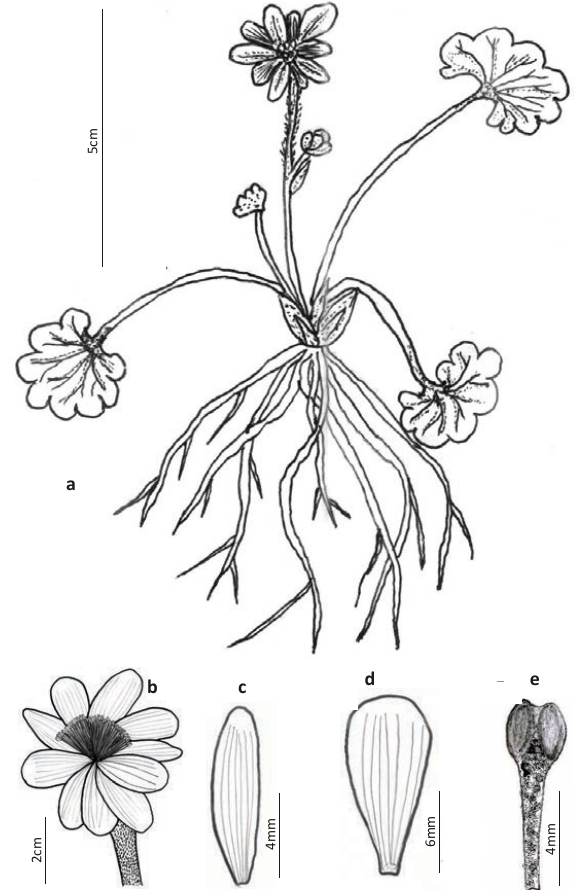
Image 1. Herbarium 10350 (ARUN!) of Oxygraphis